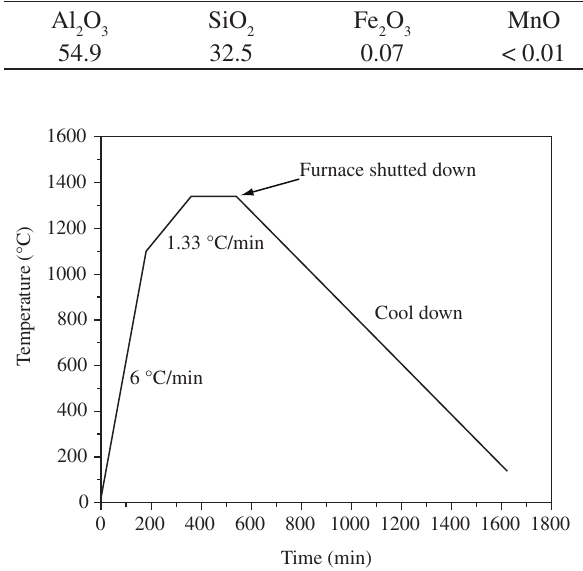
Figure 1. Thermal cycle used for the decomposition of the colorless topaz.